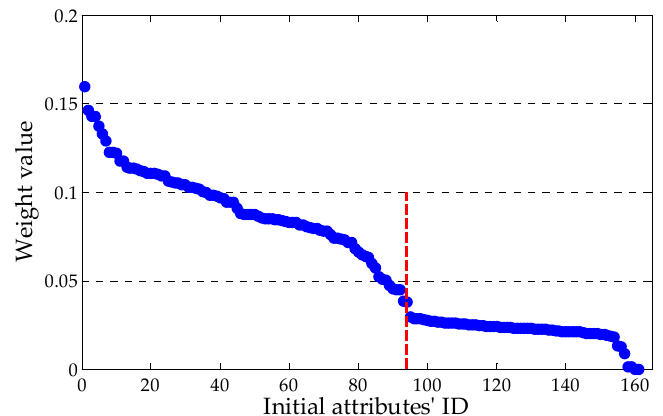
Figure 4. Weight value associated with initial attributes.